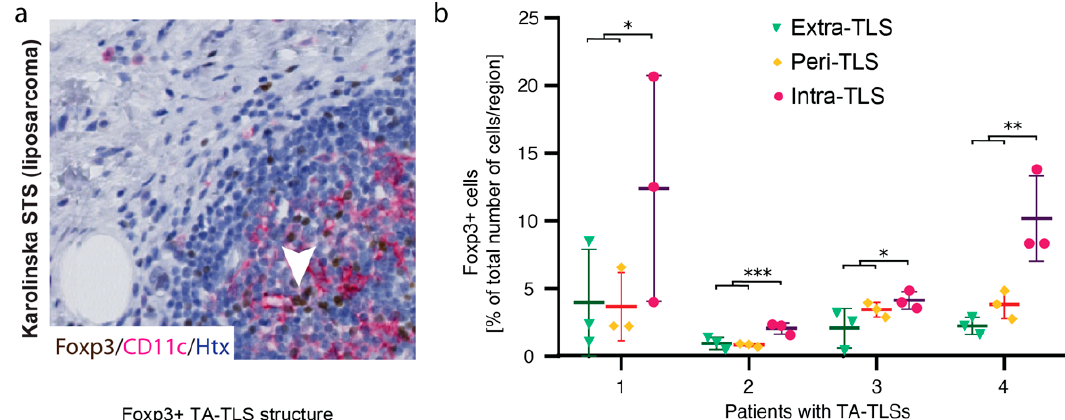
Figure 3. Foxp3+ cells reside in TA-TLSs. ( a ) Representative image of CD11c+ cells and Foxp3+ cells residing primarily within a TA-TLS (intra-TLS) and not in the peri-TLS region. ( b ) Quantification of Foxp3+ cell numbers in relation to total cell numbers and TA-TLS formation (+/ − SD). Each dot in the graph represents the QuPath image quantification result originating from one out of three middle-sized TA-TLSs. Statistical comparisons were performed with One-way Anova comparing intra-TLS regions with regions outside the TLS (close and distant). * p < 0.05, ** p < 0.01, *** p < 0.001; p < 0.05 is considered significant.